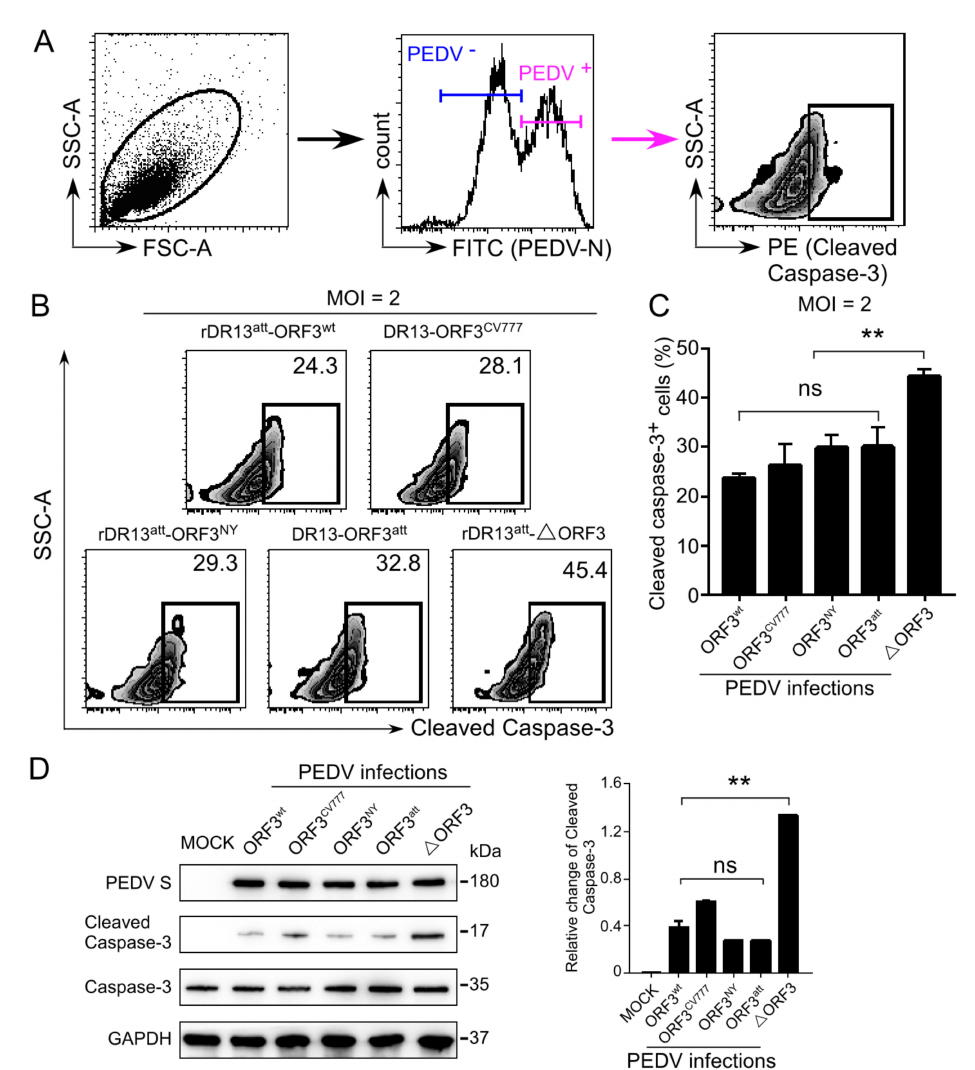
Figure 8. Detection of cleaved caspase-3 by flow cytometry and Western blot in PEDV infected Vero cells. (A ). Gating strategy to enrich for infected cells by selection on the basis of N protein detection before measuring cleaved caspase-3 by flow cytometry. ( B ). Representative flow cytometry plots indicating intracellular cleaved caspase-3 levels in Vero cells infected by rDR13 att -ORF3 wt , rDR13 att -ORF3 CV777 , rDR13 att -ORF3 NY , DR13 att , and rDR13 att - ∆ ORF3. Vero cells cultured in 6-well plates were mock-infected or infected with the viruses at an MOI of 2 for 24 h. Cells were then fixed, methanol permeabilized, and stained using rabbit anti-cleaved caspase-3 specific antibody and mouse anti-PEDV N monoclonal antibody as primary antibodies and PE-conjugated monkey anti-rabbit IgG and FITC-conjugated rat anti-mouse IgG as secondary antibodies, respectively. The percentage of cleaved caspase-3 expressing cells was quantified by flow cytometry in PEDV N protein-positive cell populations. The figure is representative of three parallel tests. ( C ). Comparative analysis of the levels of cleaved caspase-3 induced by the di ff erent viruses using flow cytometry (n ≥ 3; **, p < 0.01). ( D ). Western blot analysis of caspase-3 cleavage in infected cells. Vero cells were infected with the viruses at an MOI of 2. At 24 h.p.i., cells were harvested and lysed after which proteins were separated by PAGE and immunoblotted using antibodies recognizing PEDV S protein (top panel), cleaved caspase-3 (second panel), and caspase-3 (third panel). The blot was also reacted with rabbit polyclonal antibody against GAPDH to verify equal protein loading (bottom panel). The figures are representative of three parallel experiments. The plot at the right shows the relative levels of cleaved caspase-3 after normalization with GAPDH controls. Error bars represent standard deviations calculated from three replicates (n ≥ 3; **, p < 0.01); ns means: Not